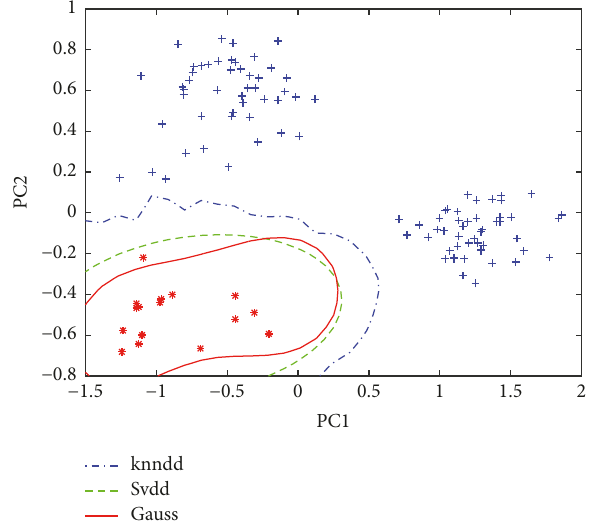
Figure 3: Application of the data description models of class A on the test set.